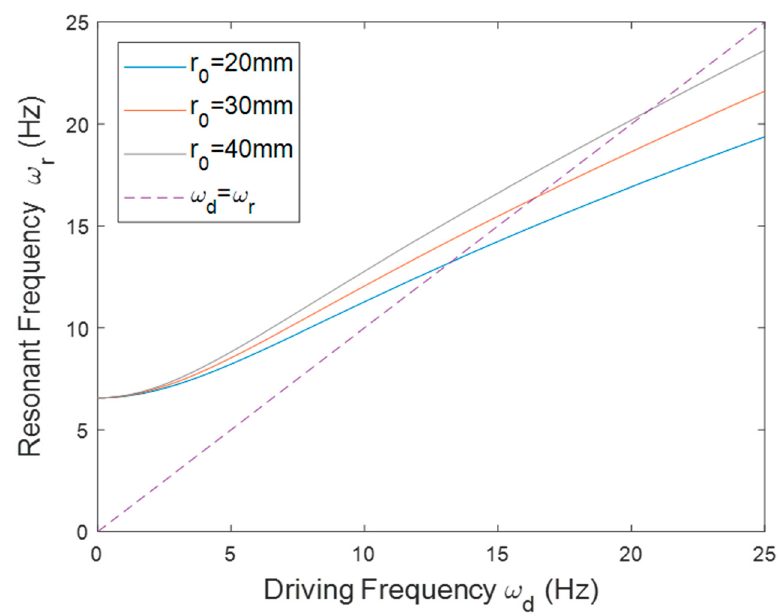
Figure 5. The resonant frequency of the PEH in the outward orientation with different r 0 .